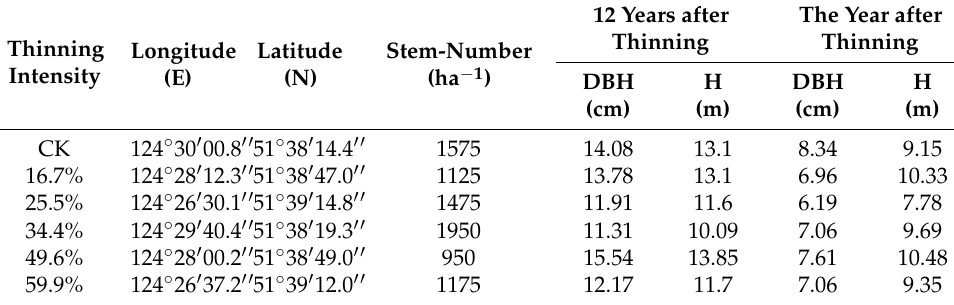
Table 1. The basic survey of six thinning